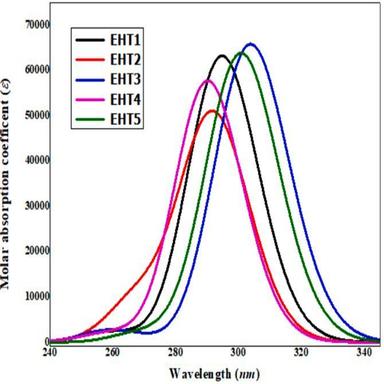
Absorption spectra of all entitled chromophores (EHT1-EHT5).